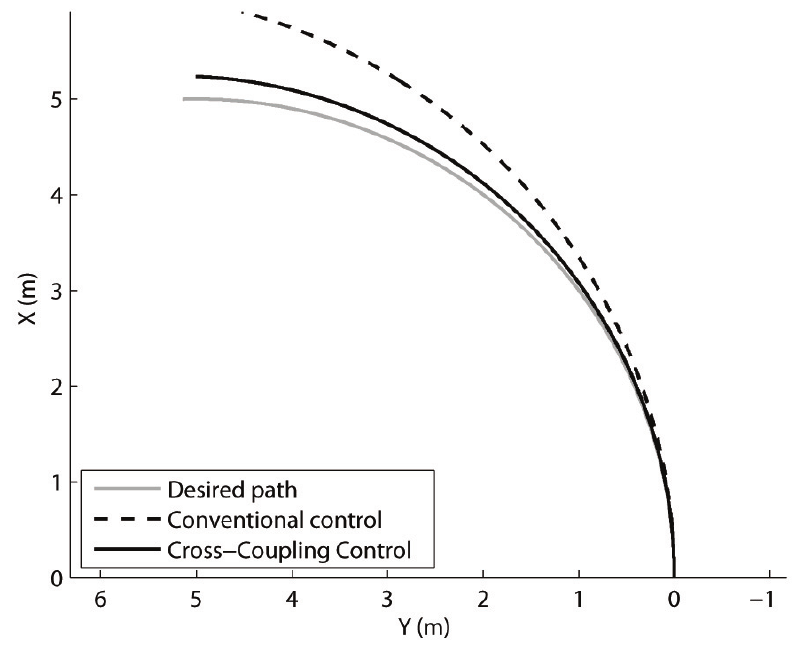
Table 2. Tracking error for the rover Dune during a turning maneuver ( V = 5 cm/s, ω = 0.05